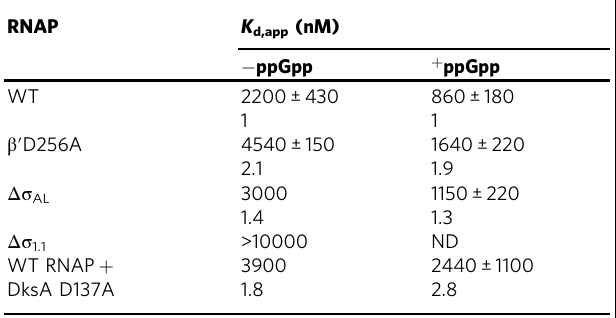
Table 1 Apparent af fi nities of DksA to wild-type and mutant RNAPs on the rrnB P1 promoter.